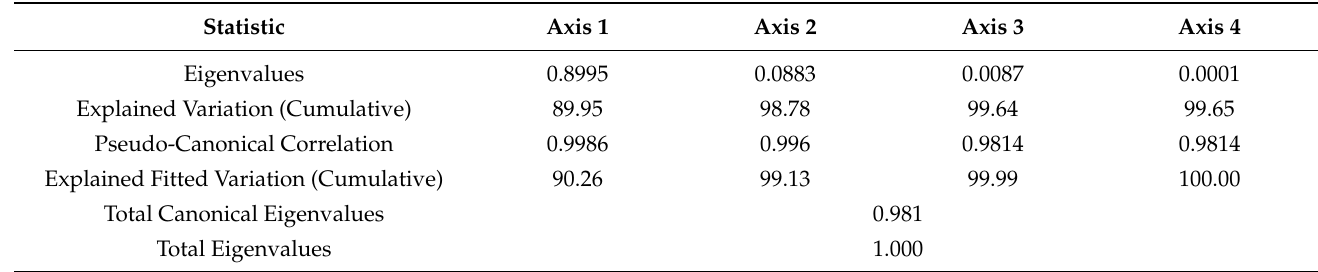
Table 2. The RDA sequencing analysis of soil enzyme activity eigenvalues and interpretations.